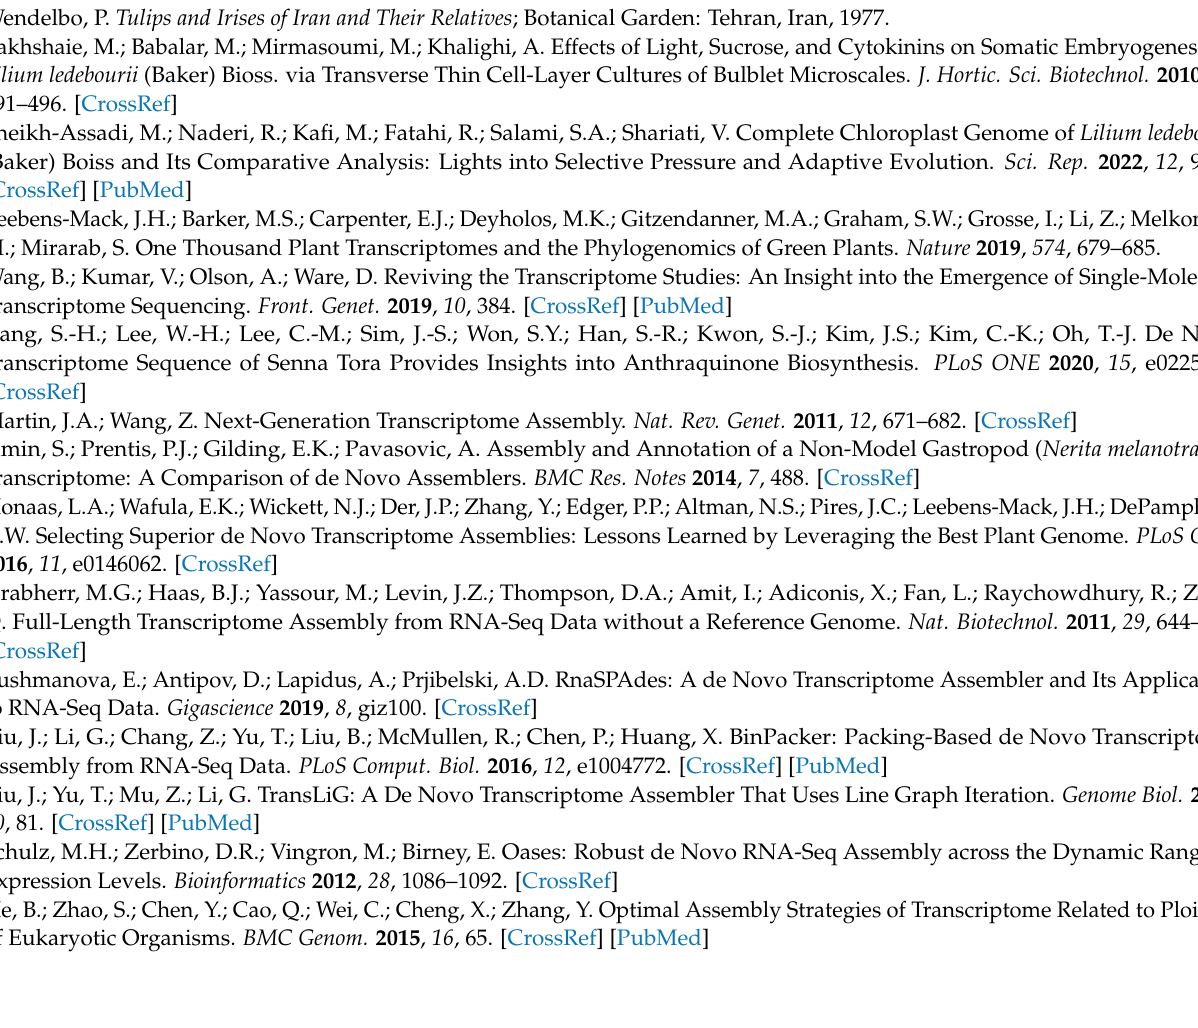
Figure S2: Cumulative number of genes that have been aligned to the Swiss-Prot database at a given coverage; Figure S3: Transcripts length and the number of transcripts per isoform among assemblies; Table S1: RNA-Quast statistical output comparison for 11 assemblies; Table S2: TransRate statistical output comparison for